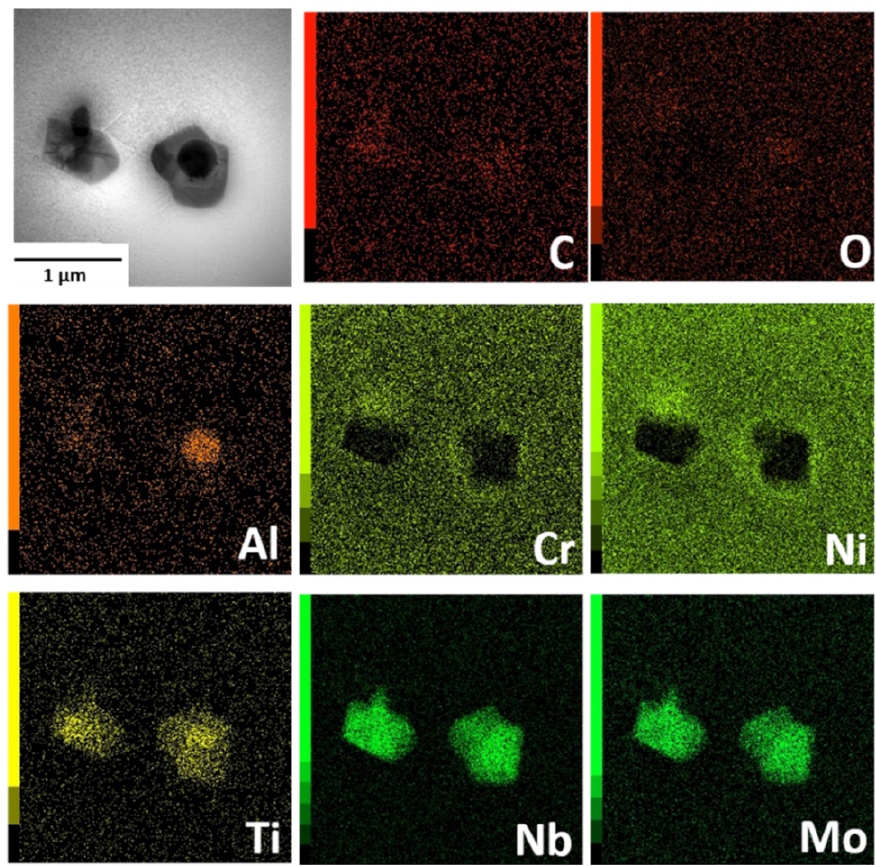
Figure 3. STEM image showing “core-shell” structures of Al 2 O 3 and (Ti,Nb)C and the corresponding WDS elemental maps of C, O, Al, Cr, Ni, Ti, Nb, and Mo of the as-built EBM IN718.